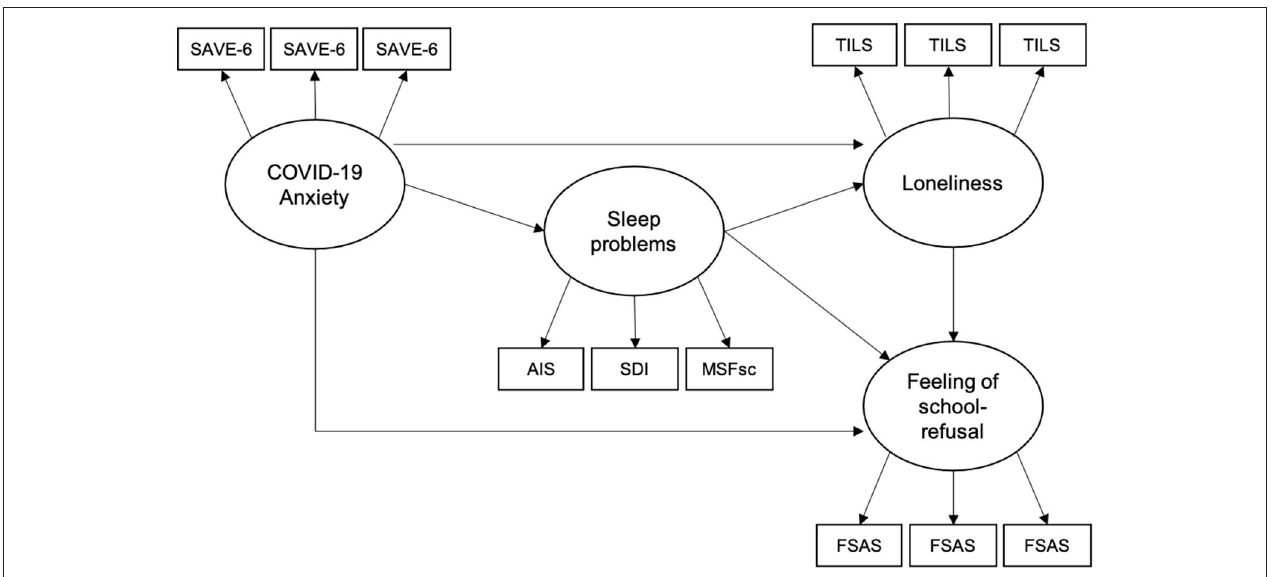
FIGURE 1 | Structural equation modeling of hypothesized